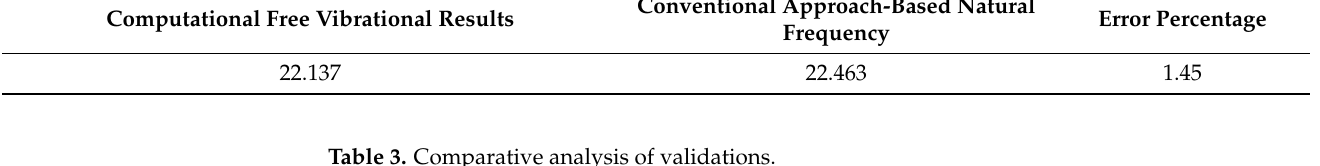
Table 3. Comparative analysis of